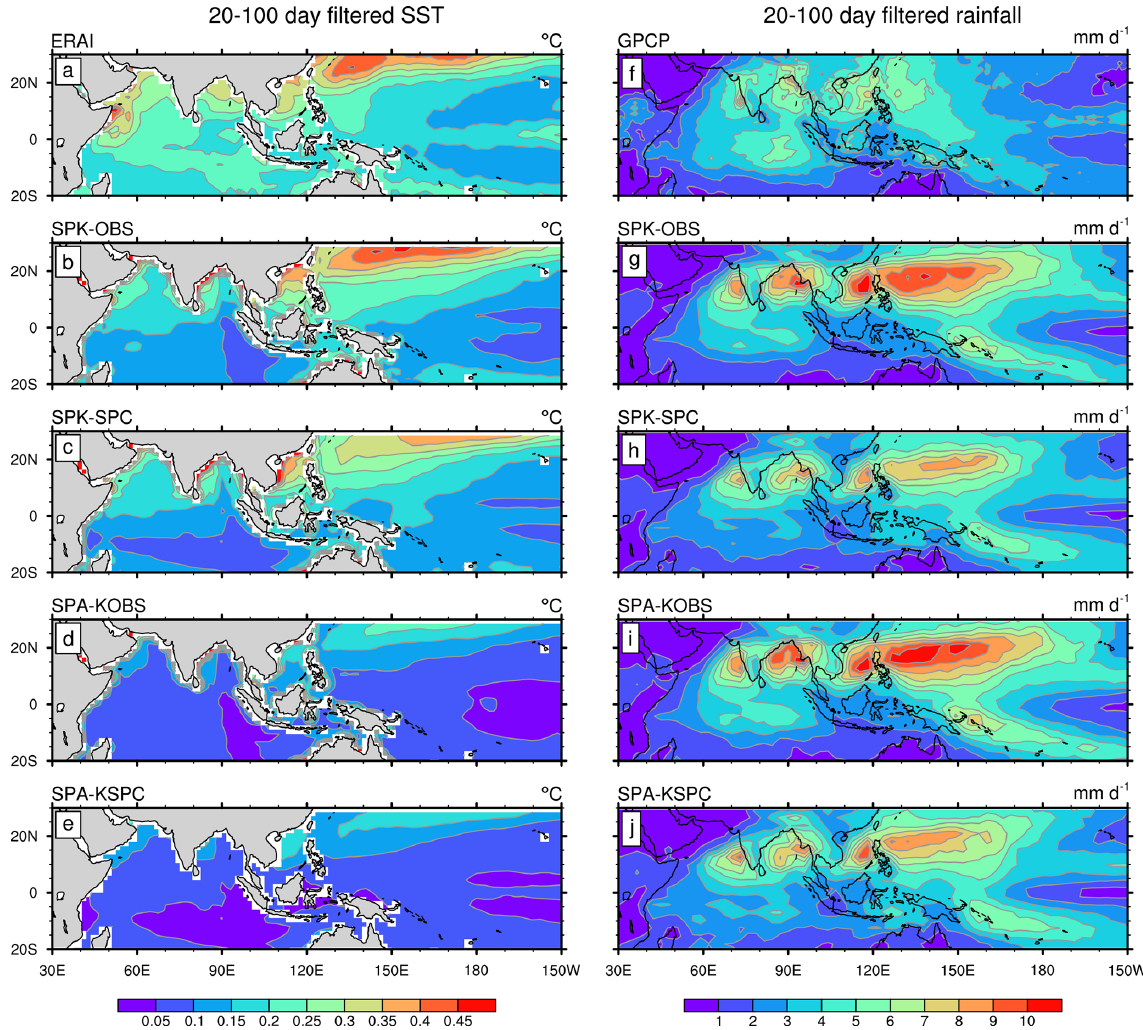
Figure 3. May–October standard deviations of 20–100d filtered (a–e) SST and (f–j) precipitation for (a, f) ERAI SST and GPCP precipita- tion, (b, g) SPK-OBS, (c, h) SPK-SPC, (d, i) SPA-KOBS, and (e, j)